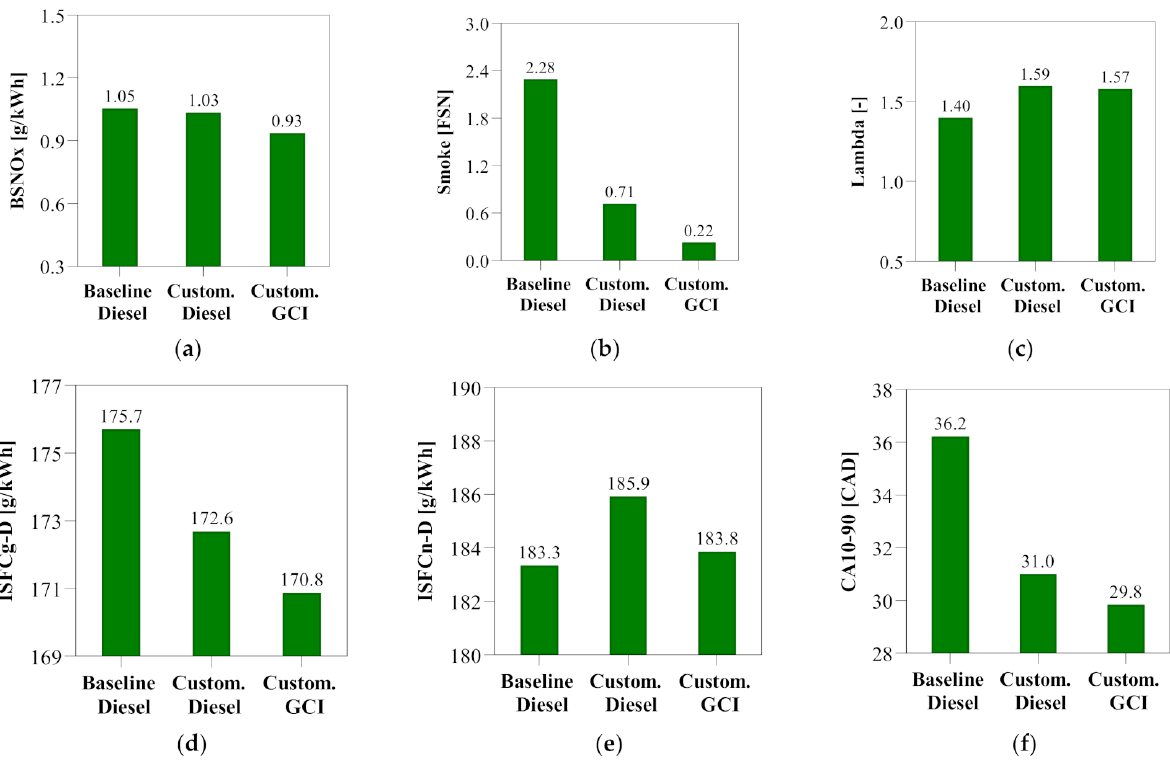
Figure 14. Overview of performance results for Baseline-Diesel, Gen1-Diesel, and Gen1-GCI at B50: ( a ) BSNOx; ( b ) smoke; ( c ) lambda; ( d ) ISFCg-D; ( e ) ISFCn-D; ( f )